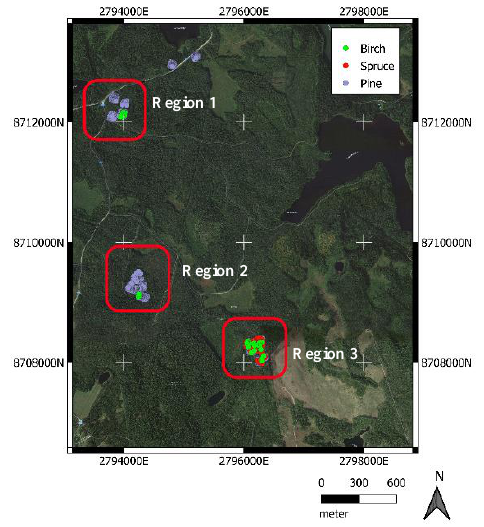
Figure 1. Location and distribution of all regions. Each class is individually colored.